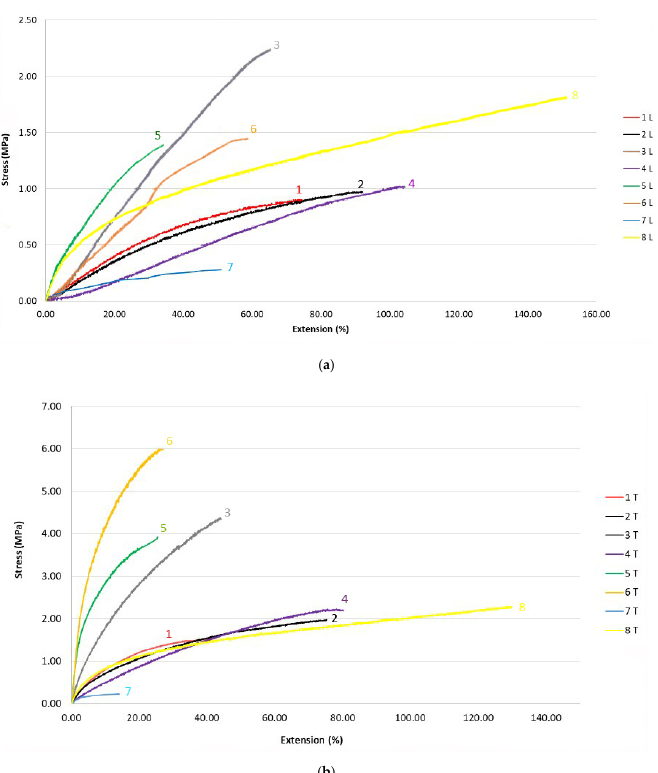
Figure 3. Stress-extension curves; ( a ) in longitudinal direction and ( b ) in transverse direction.